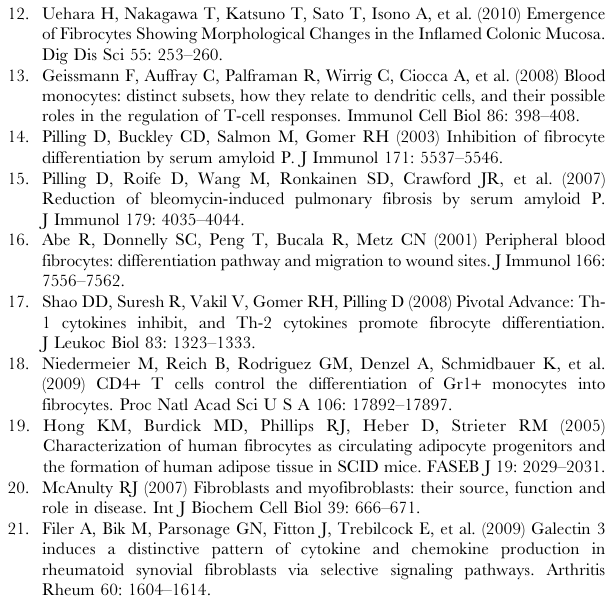
Table S3 Genes identified by SAM (0.1% FDR) when comparing macrophages, SC fibrocytes and SF fibrocytes. Table S4 Genes identified by SAM (0.1% FDR) when comparing SC fibrocytes and SF fibrocytes. Table S5 Pathways identified by DAVID analysis of the paired two-way SAM gene list of serum-free versus serum-containing fibrocytes. The pathways are listed for all pathways and those where there was a Benjamini-corrected p , 0.01 or p , 0.0001, and are grouped according to the gene